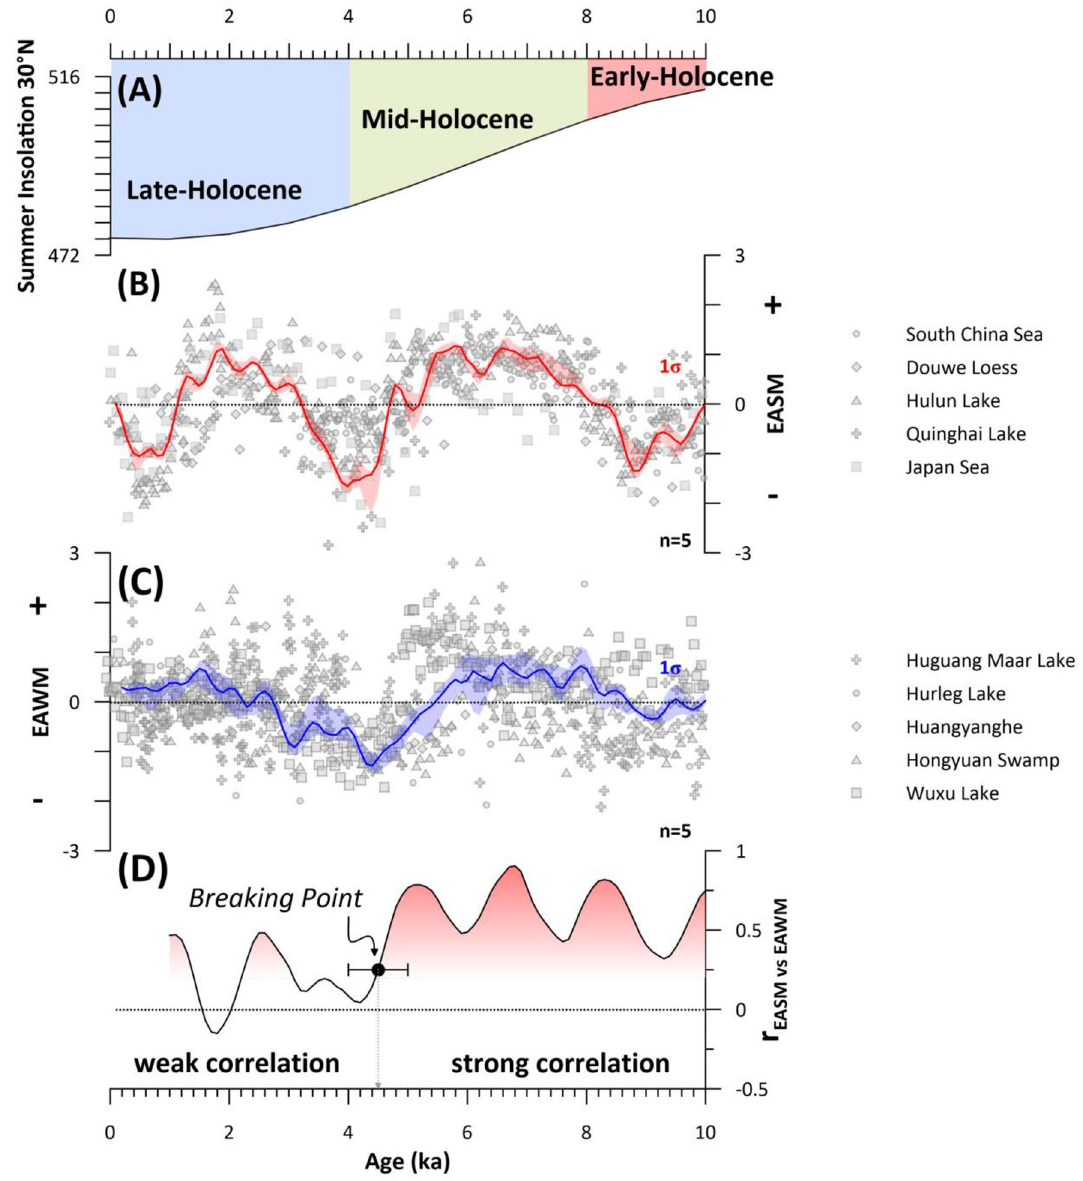
Figure 2. East Asian summer (EASM) and winter (EAWM) monsoon stacks. ( A ) 21st June (summer) insolation for 30° N 25 ; The 2.5% and 97.5% (1 σ) uncertainty intervals for the stacks are shown as shaded ( B ) red (EASM) and ( C ) blue (EAWM) areas. The detrended original data sets used for each stack are marked by grey icons according to the Figure legend. ( D ) moving Spearman correlation coefficient (r) with window size = 1 between EASM and EAWM stacks. Shading indicates strong correlation (red) to weak correlation (white). The identified break point at 4.5 ± 0.5 kyr is indicated by a black dot with error